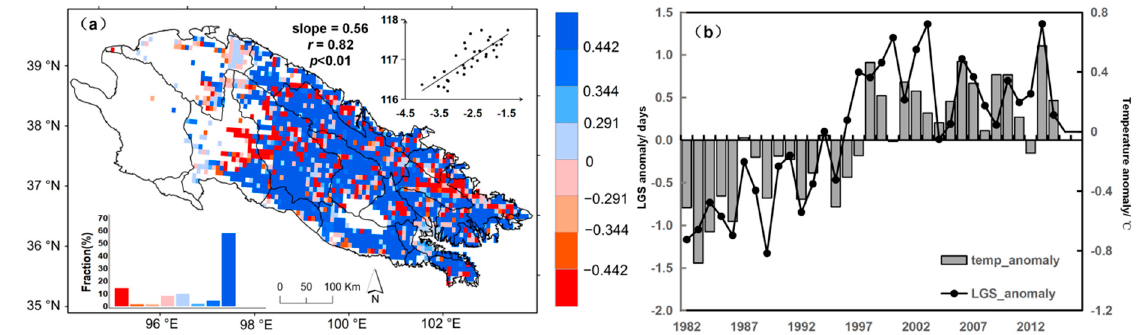
Figure 7. The spatial distribution of correlation coefficients and the interannual variation between the LGS and annual mean temperature in the Qilian Mountains. Correlation coefficient values of ± 0.442, ± 0.344, and ± 0.291 are at the significance levels of 0.01, 0.05, and 0.1, respectively. ( a ) The spatial distribution of correlation coefficients between the LGS and annual mean temperature; ( b ) interannual variation in the LGS and annual mean temperature.